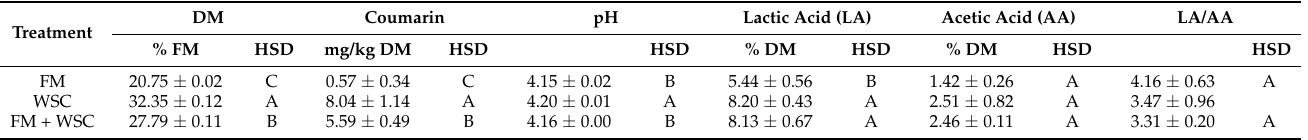
Legend to Table 5: Mean of measured values ( n = 3) ± standard deviation (SD). All parameters were recalculated to sample dry weight (DM). Different letters indicate significant differences ( p < 0.05) among individual variants in the specific parameter. FM—fodder mallow, WSC—white sweet